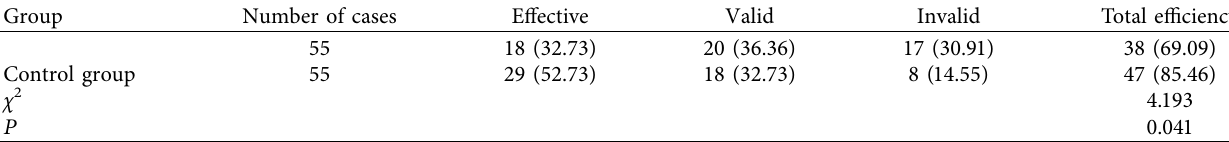
Table 1: Comparison of clinical effects between the two groups of patients ( n , (%)).